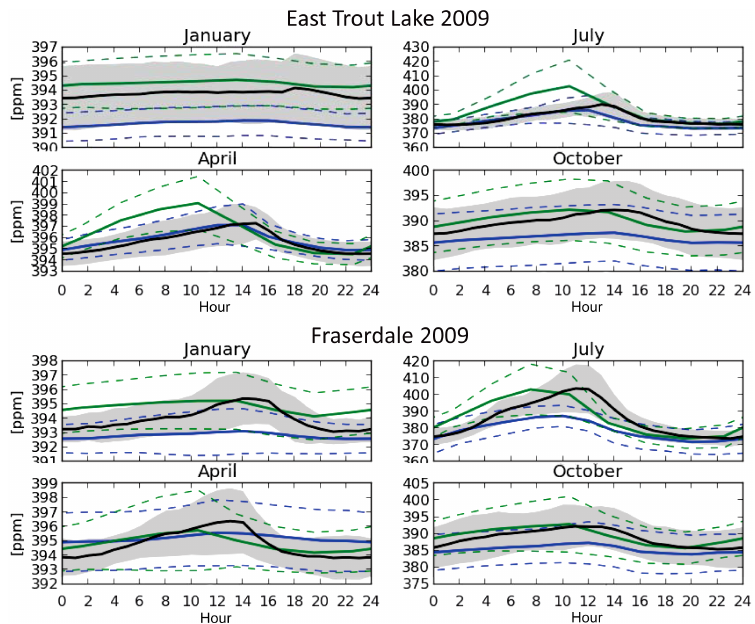
Figure 4. Mean diurnal cycle at East Trout Lake, Saskatchewan (top four panels), and Fraserdale, Ontario (bottom four panels), in 2009. Each panel shows the observed mean cycle from continuous measurements (black), CT2013B (green) and GEM-MACH-GHG with CT2013B fluxes (blue). Time is given in UTC. The four panels correspond to the months of January, July, April and October, as labelled above each panel. The grey shaded region indicates 1 standard deviation above and below observed values while the dashed lines indicate the same for the model run with the corresponding